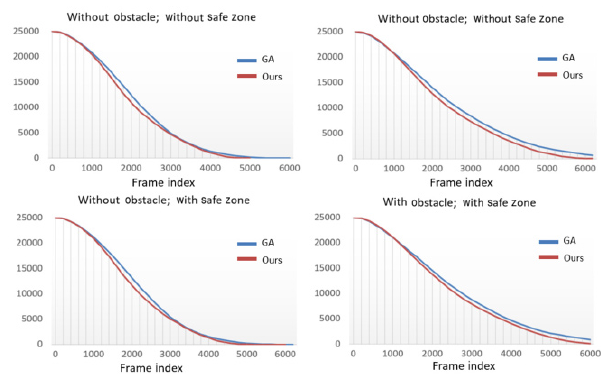
Fig. 21 Number of remaining agents over time during simulation using the GA and our method.